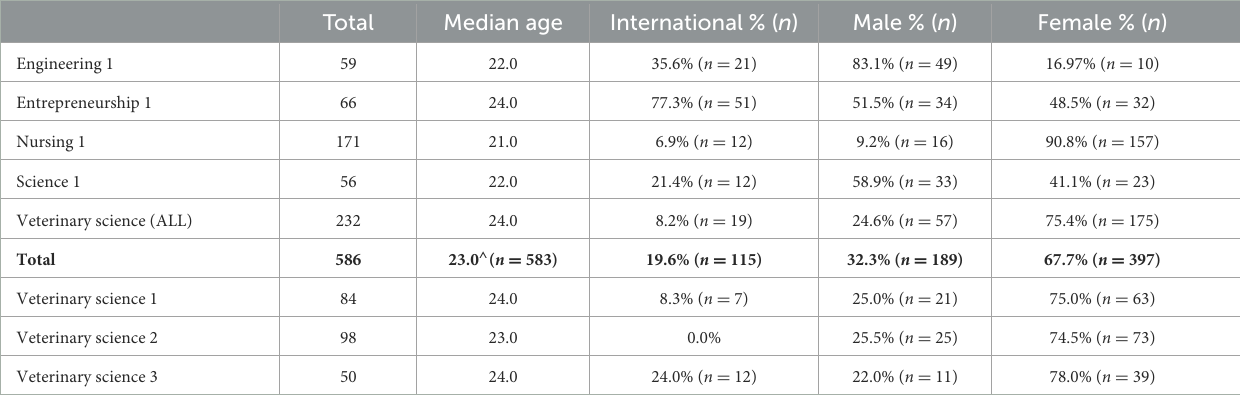
TABLE 1 Demographic profile of respondents after data hygiene and removal of eight outliers for the dependent variables of the MANOVA ( n = 586).